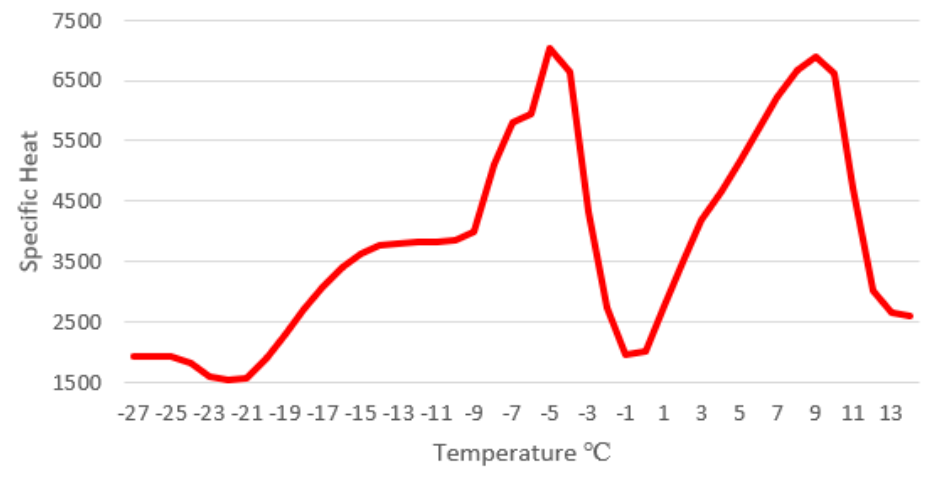
Figure 4. Specific heat temperature for sample AA-100M.